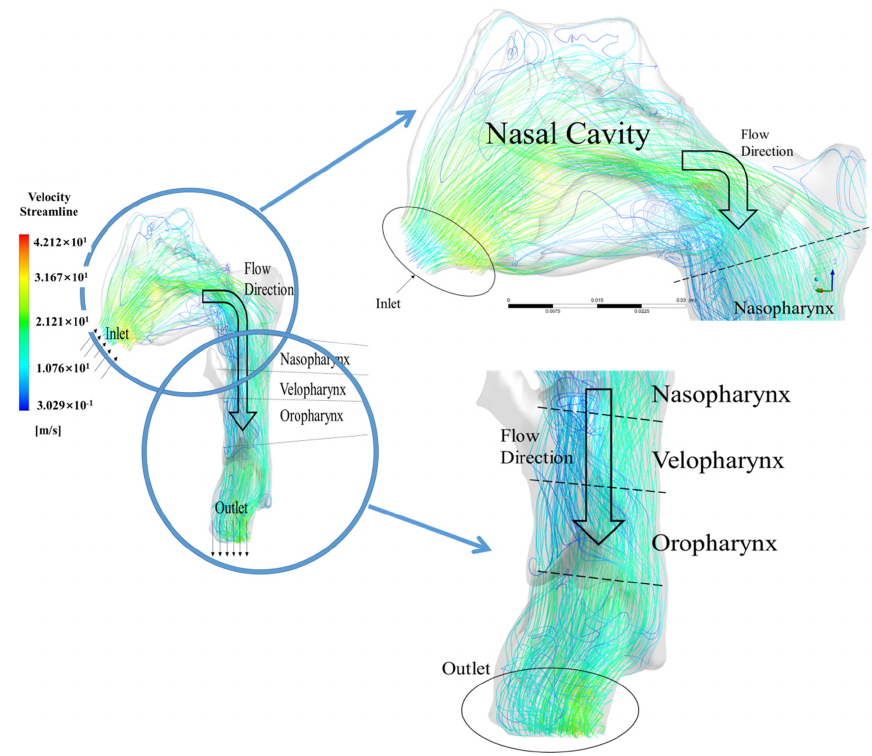
Figure 7. Streamline distribution in patient 10 during inspiration (t = 1.25 s). Processes 2020 , 8 , x FOR PEER REVIEW The velocity profile of the central line of planes 1–5 of representative patient 7 are shown in Figure 8. The velocity profile was different at each point in time. The pressure drop distribution of planes 1–5 of representative patient 7 are shown in Figure 9. It was observed that a large external low pressure area occurred at T 1 and stabilized at T 2 .